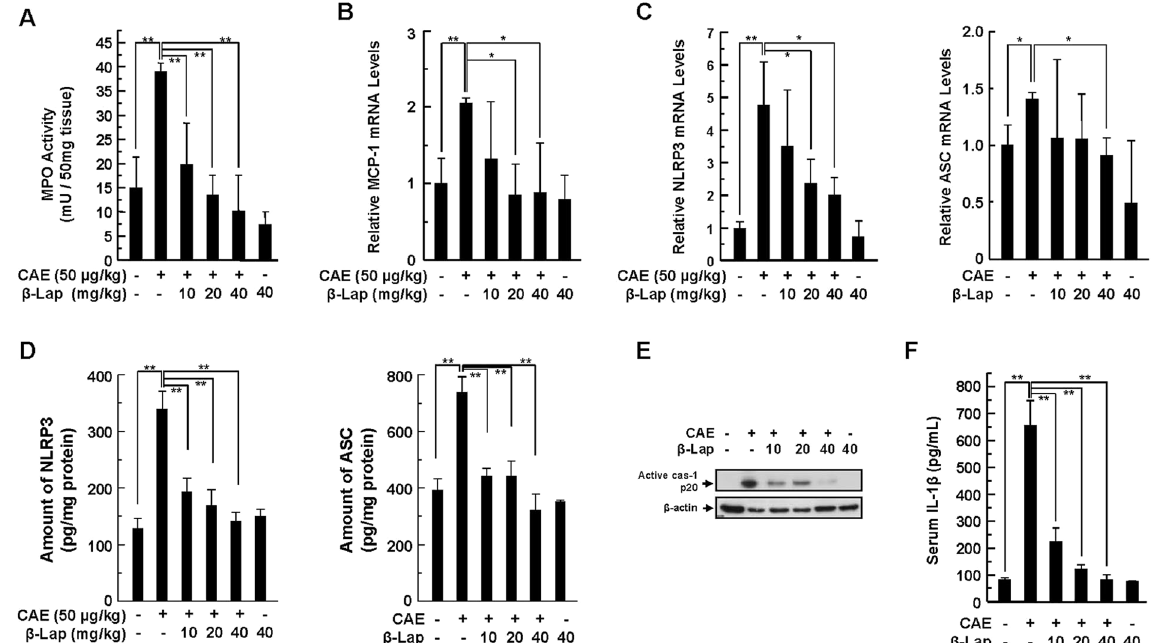
Figure 2. Effect of β -Lap on pancreatic MPO activity and inflammatory changes during caerulein-induced AP. ( A ) Pancreatic MPO activity. ( B , C ) Pancreatic mRNA levels of MCP-1, NLRP3, and ASC measured using qRT- PCR. ( D , E ) Total pancreatic homogenates were obtained from each experimental group and pancreatic protein levels of NLRP3 and ASC were measured by ELISA, and blotted with anti-caspase-1. ( F ) Serum IL-1 β levels analysed by ELISA. Each value represents the mean ± SD ( n = 5). * P < 0.05, ** P <